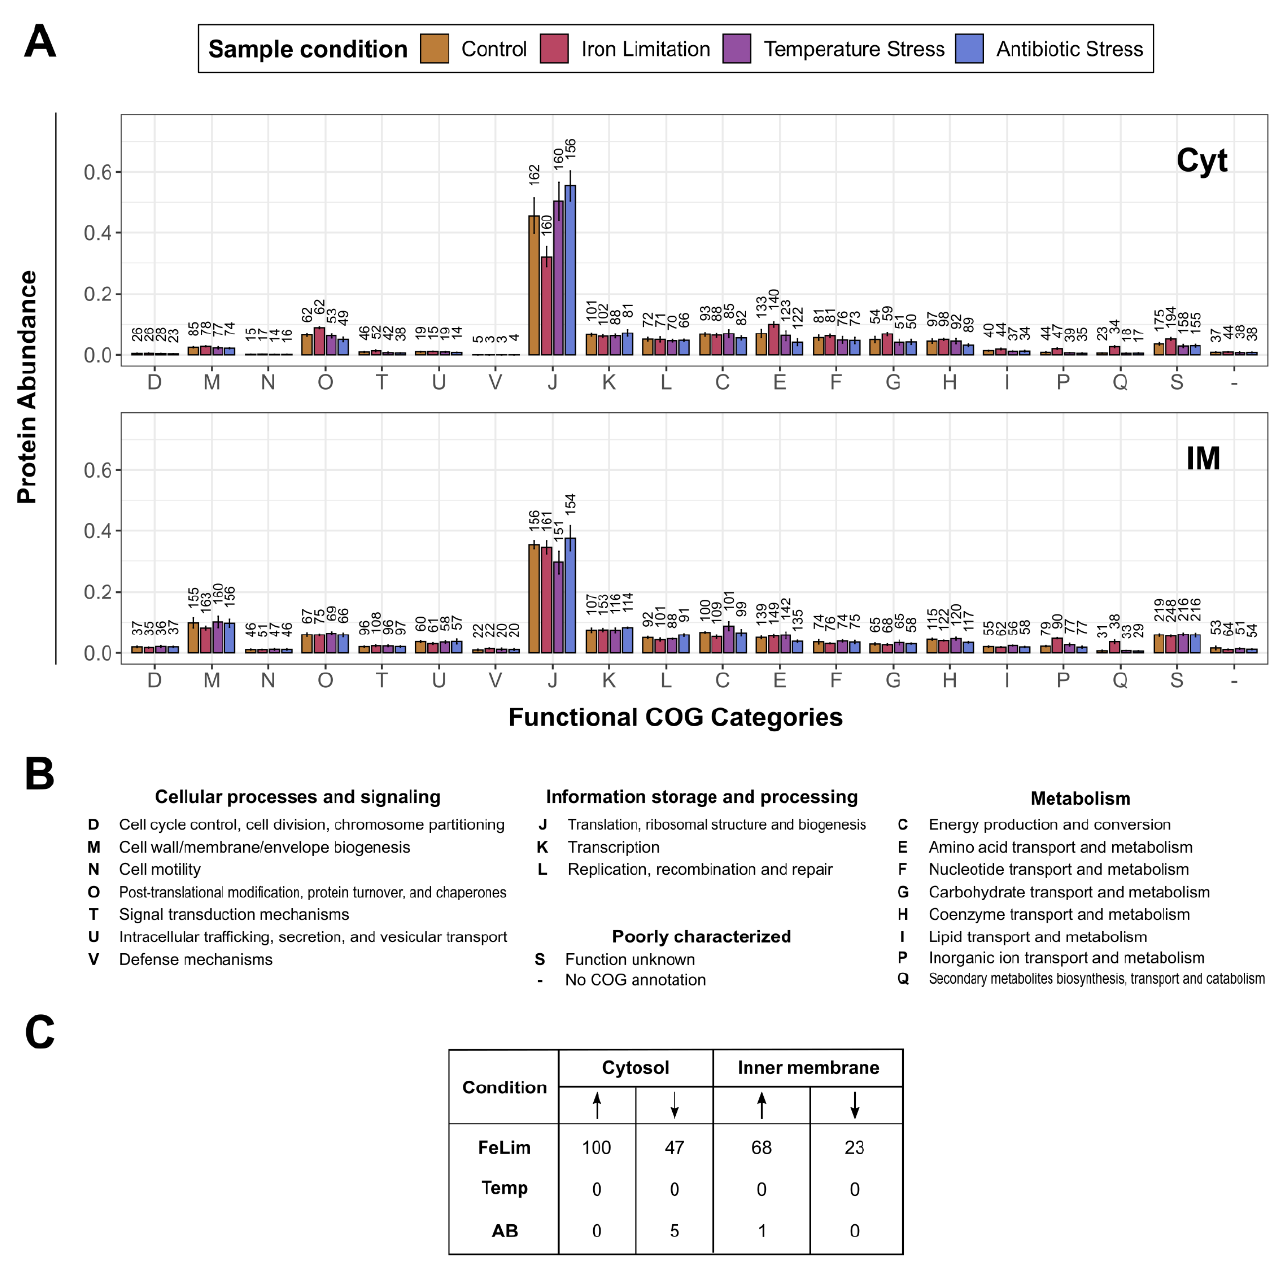
Figure 3. Overview of the functional protein compositions in the enriched cytoplasmic and inner membrane fractions. ( A ) Quantified proteins were grouped into functional categories that were predicted by eggNOG (description of the one-letter code in ( B )). The protein abundances of each bin were normalized to the total protein abundances in the enriched fraction and condition. The distribution within the conditions in the enriched cytosol (Cyt) and inner membrane (IM) fractions were plotted. The number of quantified proteins within the conditions is indicated above the bars. Error bars indicate standard deviations between replicates ( n = 4). ( B ) COG one-letter code descriptions. ( C ) The number of proteins with significantly changed abundance. Arrow pointing up: significantly upregulated; Arrow pointing down: significantly downregulated. Detailed data are available in Table S3.